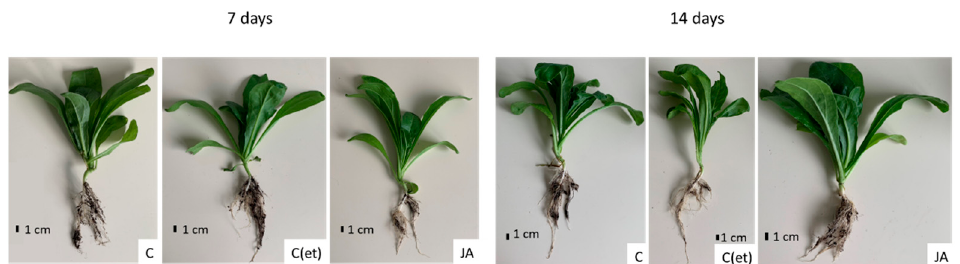
Figure 10. Control and JA—treated plants after 7 and 14 days of cultivation.